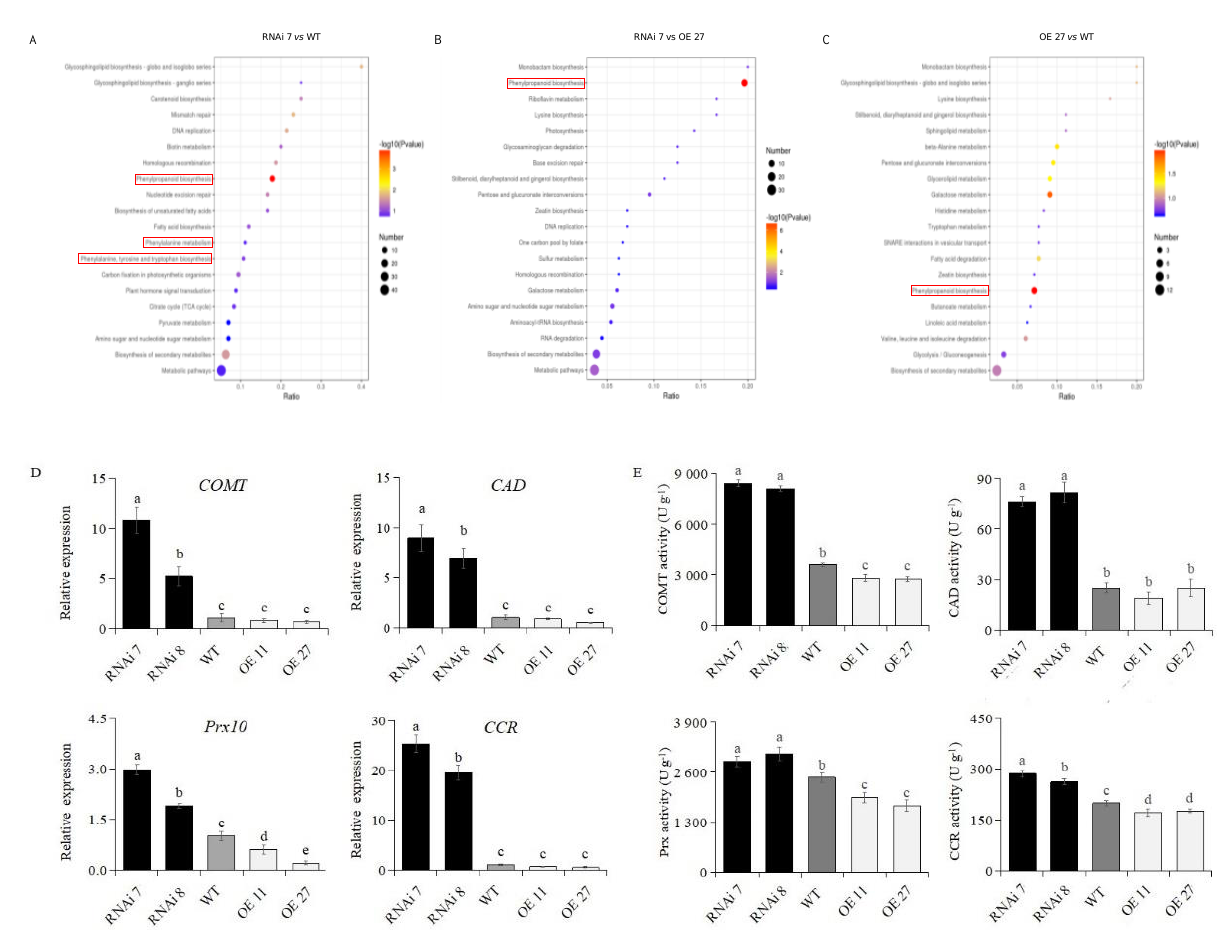
Figure 5. KEGG enrichment and analysis of lignin biosynthesis genes expression and enzyme activities. KEGG enrichment analyses of potato skins in three comparisons, RNAi 7 vs. WT ( A ), RNAi7 vs. OE27 ( B ) and OE27 vs. WT ( C ), at the 45th day of storage. The red rectangle highlights the lignin metabolism pathway. Gene expression ( D ) and enzyme activities ( E ) of COMT, CAD, Prx and CCR were investigated by qPCR assay and enzyme activities assay kits, respectively, at the 45th day. The data are means ± SD of four biological experiments with triplicate measurements in each experiment. Different letters indicate significant differences at p < 0.05.